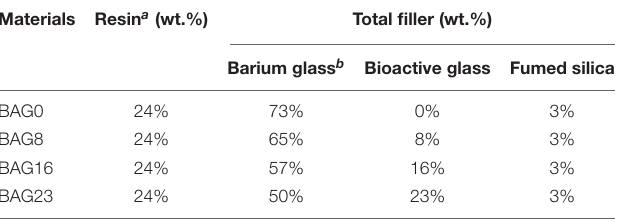
TABLE 1 | The composition of different parameters for BAG-modified composite resin